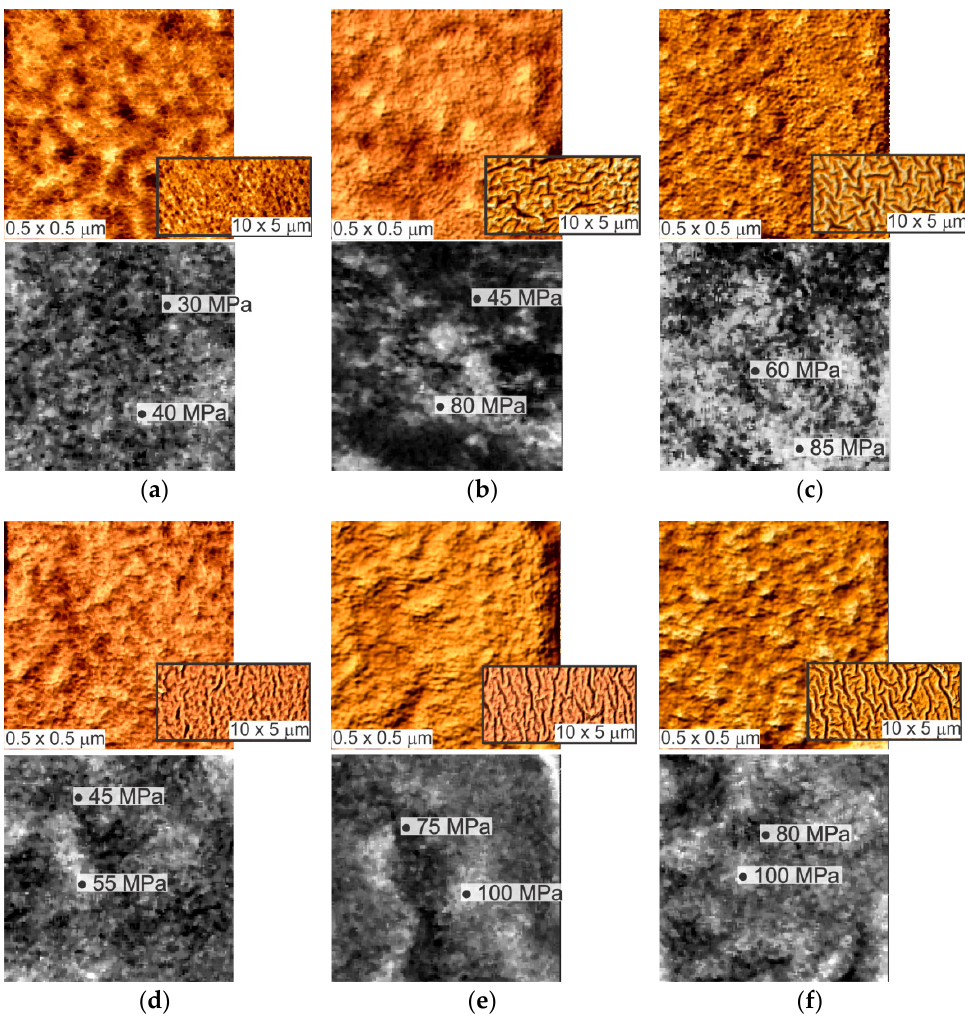
Figure 2. Surface topography and elastic modulus maps of polyurethane treated in Ar/C 2 H 2 plasma for 30 s ( a ), 60 s ( b ), 120 s ( c ) and after argon post-treatment ( d – f ).